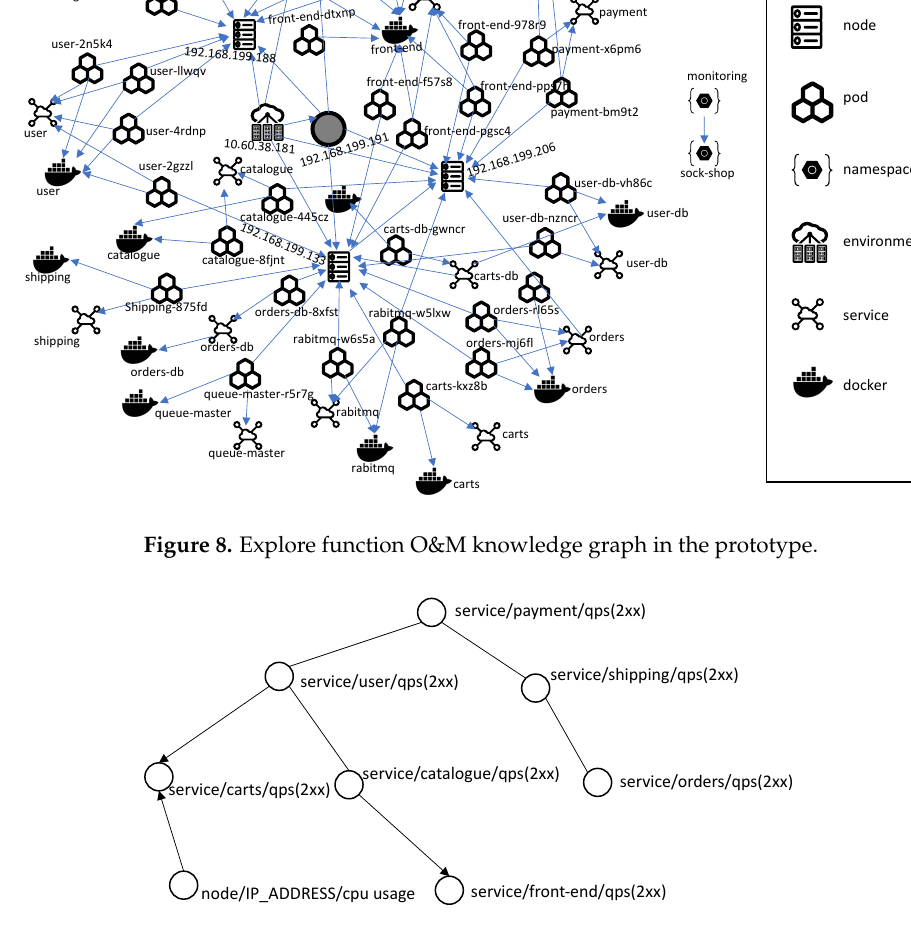
Figure 9. Causality search function in the